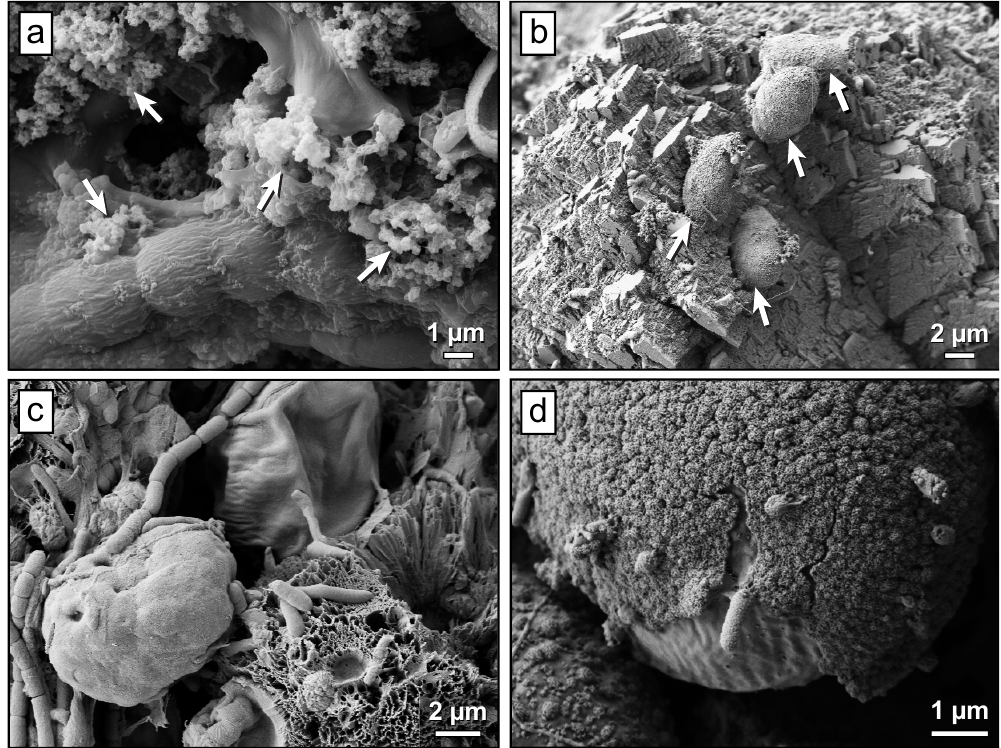
Figure 5. Representative scanning electron micrographs from carbonate precipitation experiments showing microbe-mineral interactions. ( a ) Fine-grained carbonate precipitates (arrows) formed in association with filamentous cyanobacteria in experiments using water from the open pit pond at Clinton Creek. ( b ) Algal cells (arrows) on the surface of Ca-carbonate aggregate and ( c ) filamentous cyanobacteria on a large (~10 μ m wide) rosette of dypingite (bottom right). Solutions produced by leaching of Diavik ( b ) and Mount Keith ( c ) tailings using acetic acid, which acted as an additional carbon source. ( d ) Algal cell completely encrusted by fine-grained Mg-Ca-silicates from solutions produced by leaching of Mount Keith tailings